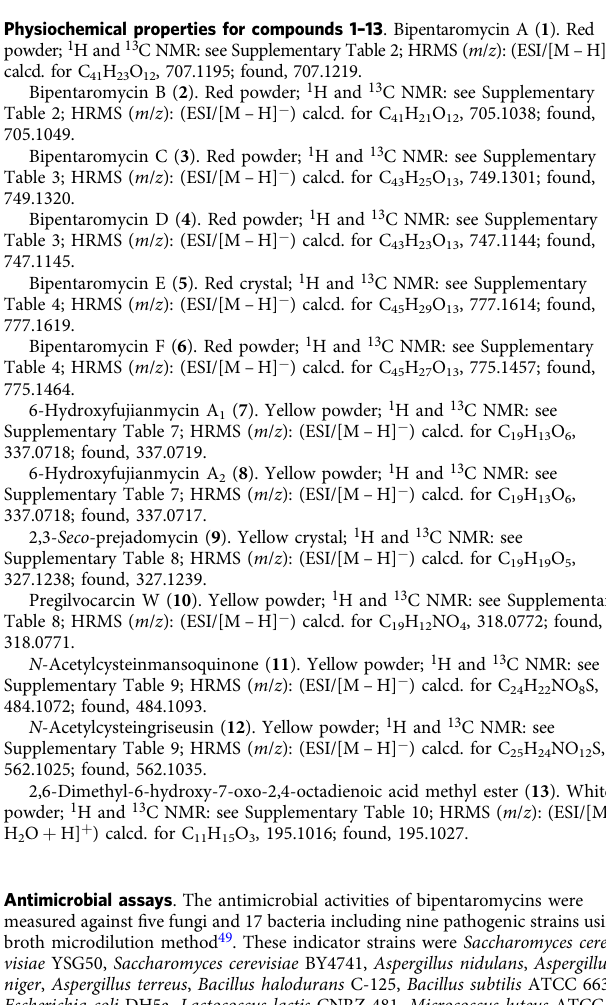
Supplementary Table 8; HRMS ( m / z ): (ESI/[M – H] − ) calcd. for C 19 H 19 O 5 , 327.1238; found, 327.1239. Pregilvocarcin W ( 10 ). Yellow powder; 1 H and 13 C NMR: see Supplementary Table 8; HRMS ( m / z ): (ESI/[M – H] − ) calcd. for C 19 H 12 NO 4 , 318.0772; found, 318.0771. N -Acetylcysteinmansoquinone ( 11 ). Yellow powder; 1 H and 13 C NMR: see Supplementary Table 9; HRMS ( m / z ): (ESI/[M – H] − ) calcd. for C 24 H 22 NO 8 S, 484.1072; found, 484.1093. N -Acetylcysteingriseusin ( 12 ). Yellow powder; 1 H and 13 C NMR: see Supplementary Table 9; HRMS ( m / z ): (ESI/[M – H] − ) calcd. for C 25 H 24 NO 12 S, 562.1025; found, 562.1035. 2,6-Dimethyl-6-hydroxy-7-oxo-2,4-octadienoic acid methyl ester ( 13 ). White powder; 1 H and 13 C NMR: see Supplementary Table 10; HRMS ( m / z ): (ESI/[M